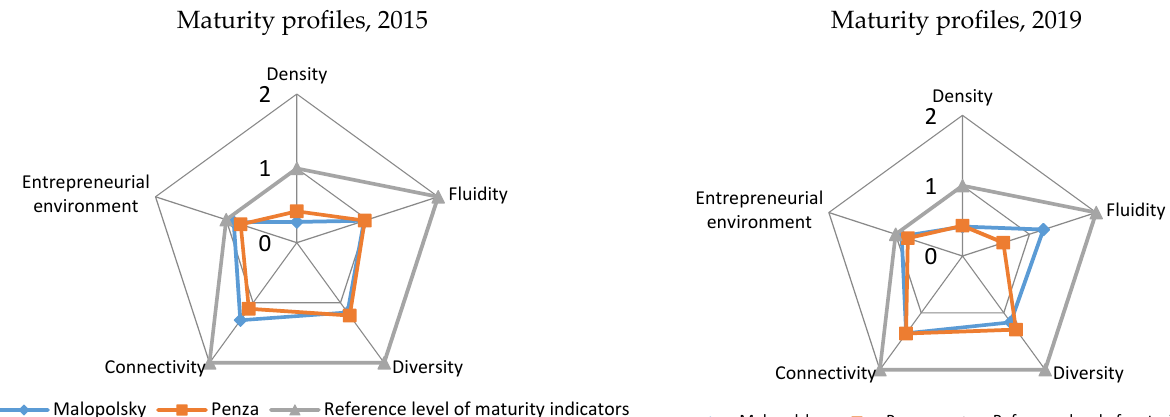
Figure 4. Maturity profiles of the entrepreneurial ecosystems in the Małopolska and the Penza regions (2015, 2019). Source: Own elaboration.